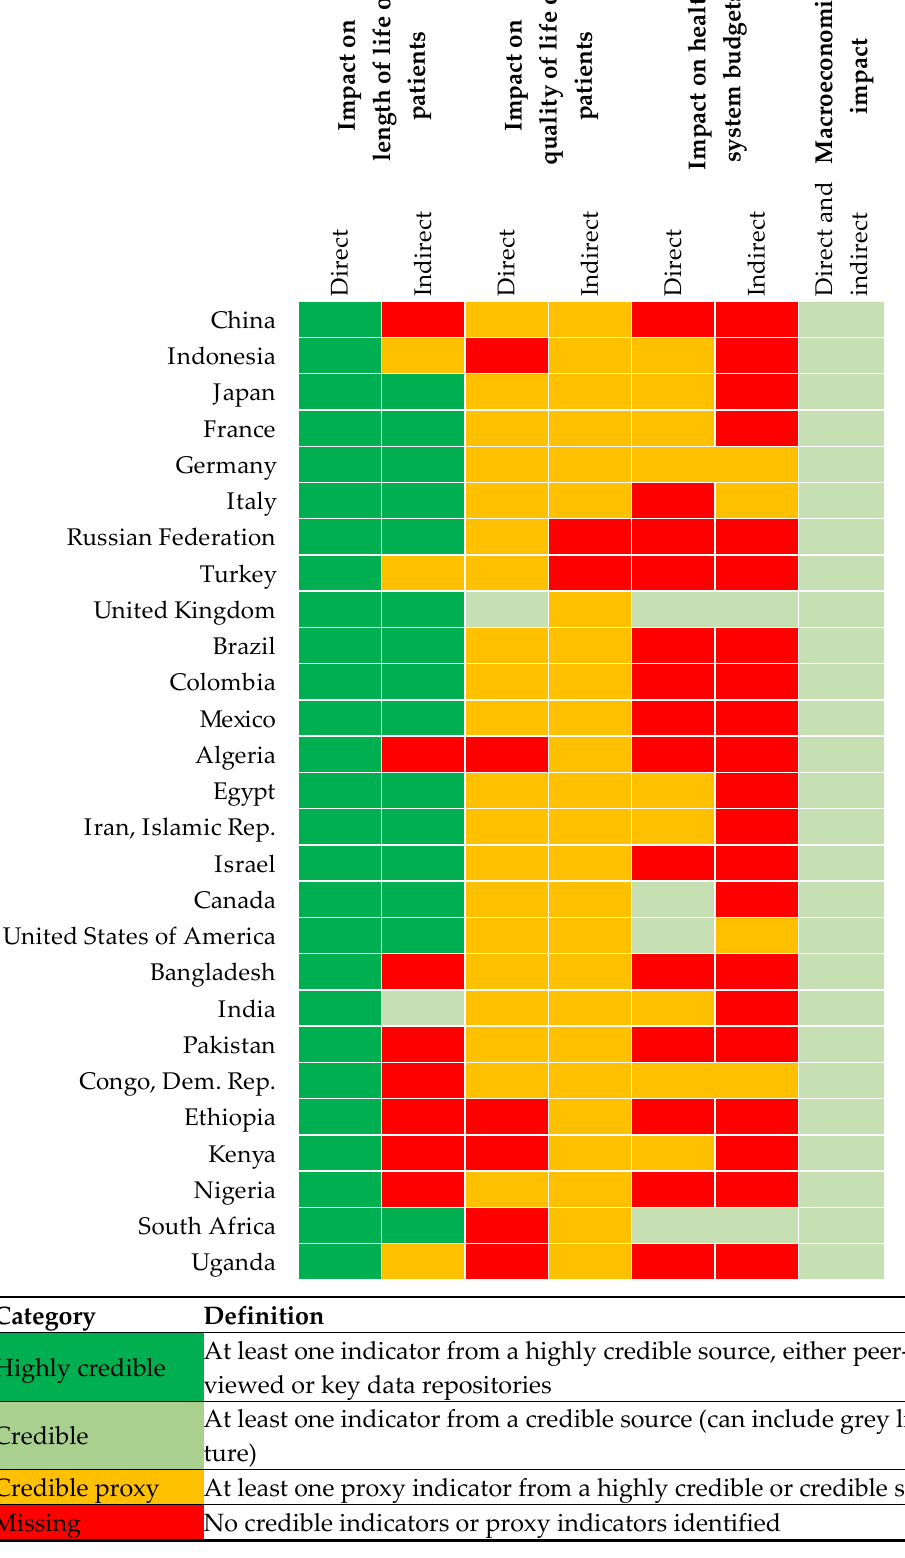
Figure 1. Heatmap of available evidence by value element and region, colour-coded by level of credibility.